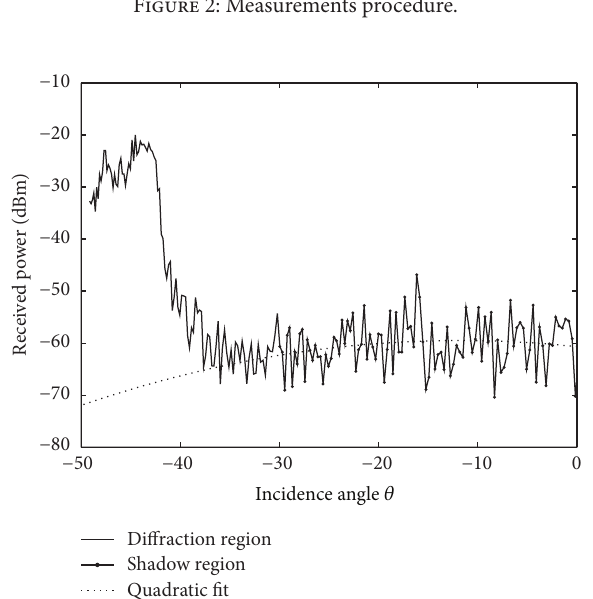
markers corresponds to measurements in the shadow region of the